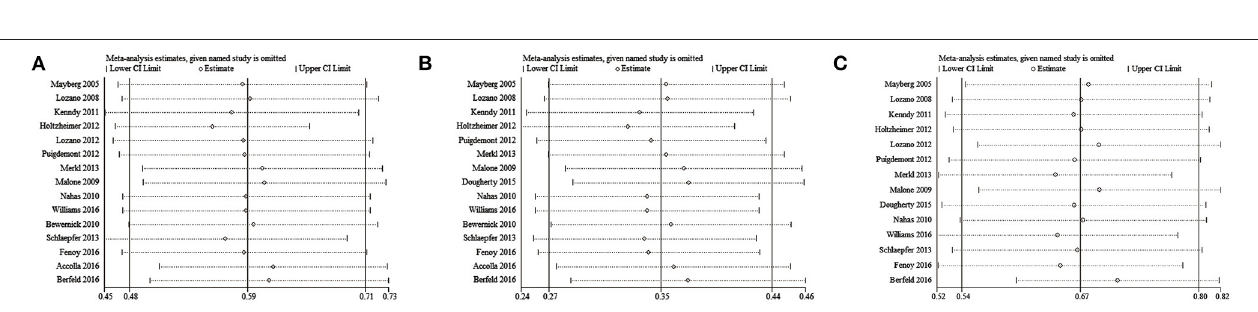
FIGURE 5 | Sensitivity analysis. (A) Response rates; (B) Remission rates; (C) Adverse events